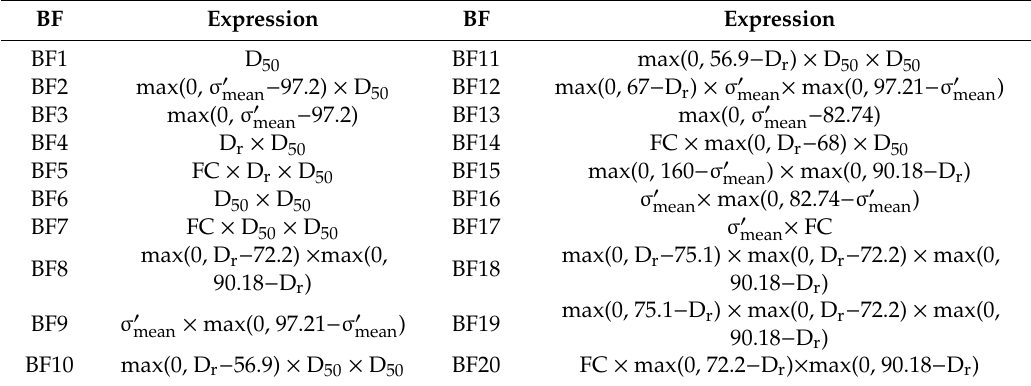
Table 2. Expressions of basis functions (BFs) for the MARS model.